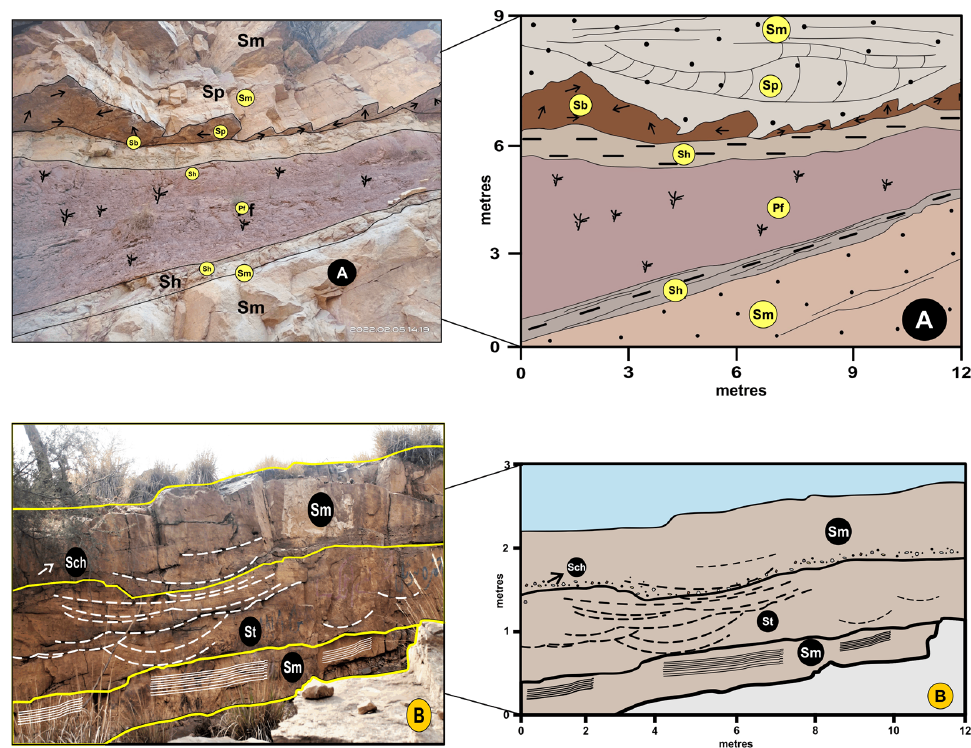
Figure 6. ( A ) Field sketch showing Planar cross-bedding element (SCp) and traces sandstone element (ST), asymmetrically filled with facies Sb, Pf, Sm, and Sh in Pab Formation. Arrows show the bioturbation in the Sb facies and heavy lines delineate the facies boundaries; and ( B ) photomosaic of trough cross-bedding element (SCt) in the middle part of the study area. This element is filled with facies Sm, St, and Sch in the Pab Formation. Heavy lines delineate the facies boundaries while the dashed lines show the trough